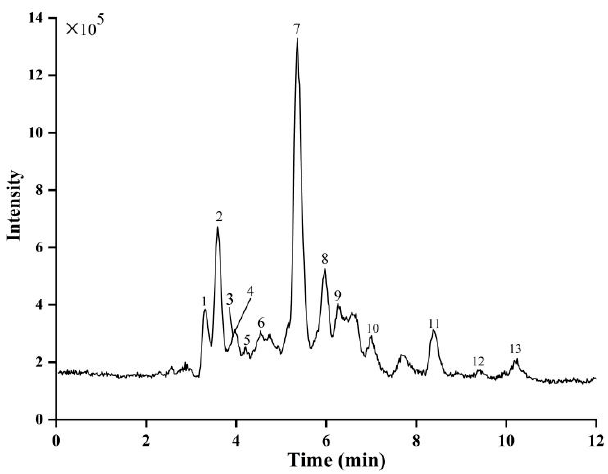
Figure 6. The total ion chromatogram (TIC) of the EtOAc fraction by HPLC-MS. By comparing the retention time, MS, and MS/MS fragmentation pattern with the related literature, peak 1 was detected; the precursor ion [M − H] − was located at m / z 353.085 (C 16 H 18 O 9 ), the major fragment ion was located at m / z 191.055, and referring to the literature, it was identified as chlorogenic acid (quinic acid) [27]. Research has shown that chlorogenic acid protects against tissue damage caused by ischemia/reperfusion,